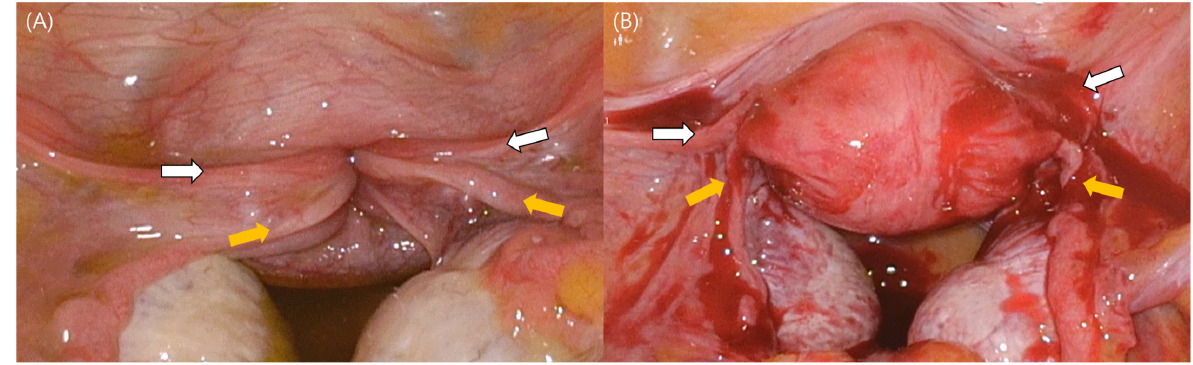
Figure 2. Laparoscopic visualization of non-puerperal uterine inversion. The classic “flowerpot” appearance can be seen. White arrows indicate both round ligaments, while yellow arrows show bilateral fallopian tubes. ( A ) During laparoscopy, a second-degree uterine inversion was confirmed. ( B ) Laparoscopic visualization of normal-sized uterus with smooth surface.